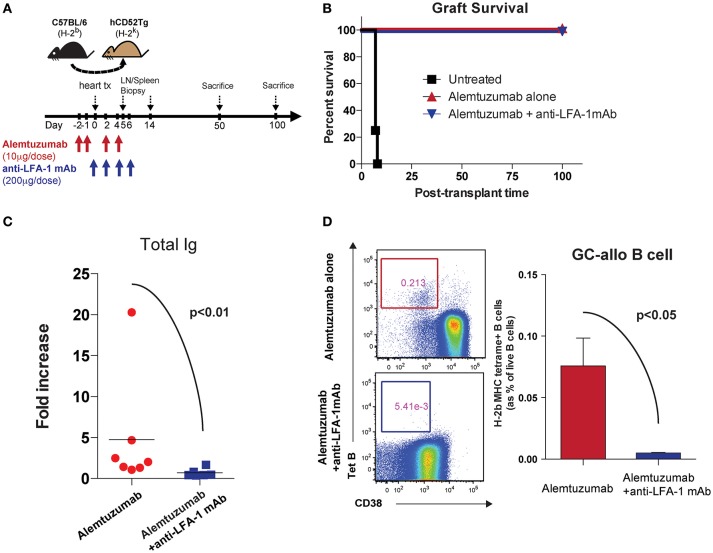
Pre-emptive anti-LFA-1 mAb treatment reduced post-transplant DSA and allo-specific B cells in alemtuzumab treated hCD52Tg cardiac allograft recipients. (A) Dosing scheme and experimental design. (B) Graft survival of human CD52Tg mice received B6 cardiac allografts. Alemtuzumab treatment (IP, 10 μg per dose at POD −2, −1, 2, 4,) with or without anti-LFA-1 mAb (KBA-1; 200 μg per dose at POD 0, 2, 4, 6) significantly prolonged graft survival (MST >100 d) vs. untreated (MST = 9 d). (C) Donor-specific antibody measured by T cell flow crossmatch was significantly decreased in anti-LFA-1 treatment in Alemtuzumab induced CAMR model. (D) Allo-specific B cells visualized by MHC (H-2Kb/Db) tetramer were significantly reduced with anti-LFA-1 mAb treatment from the spleen at POD100.